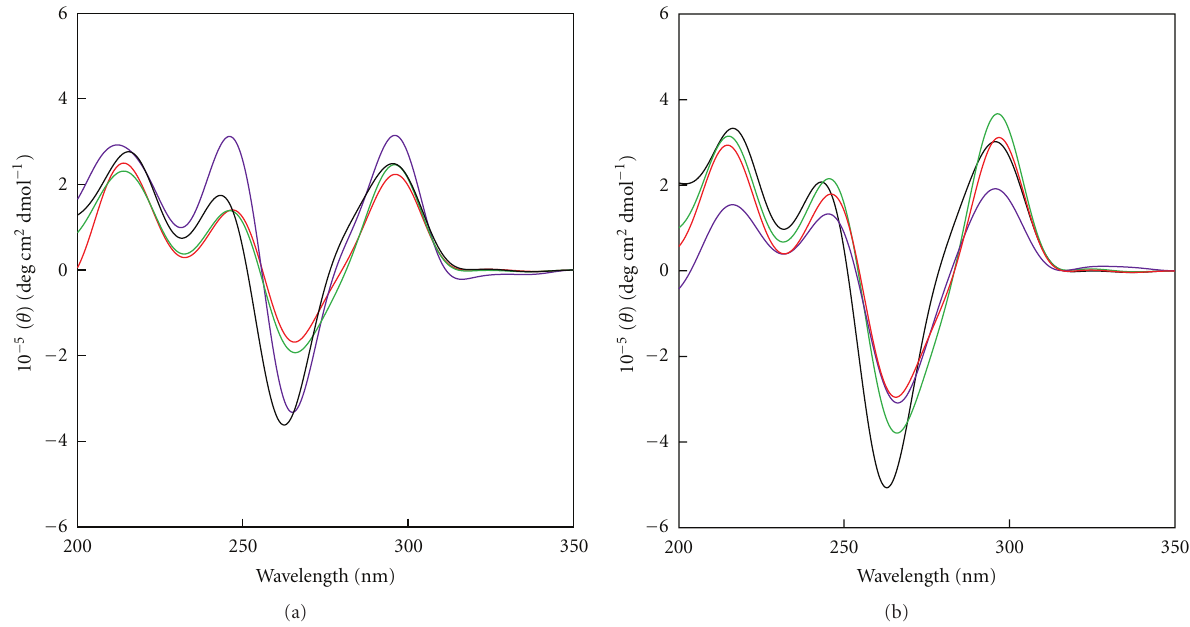
Figure 2: CD spectra for 20 µ M AP-0 (black), AP-1 (green), AP-2 (purple), and AP-3 (red) in a bu ff er of 100mM NaCl, 50mM Tris-HCl (pH 7.0), and 1mM Na 2 EDTA at 0wt% (0molL − 1 ) (a) and 40wt% (2molL − 1 ) PEG200 (b) at 4 ◦